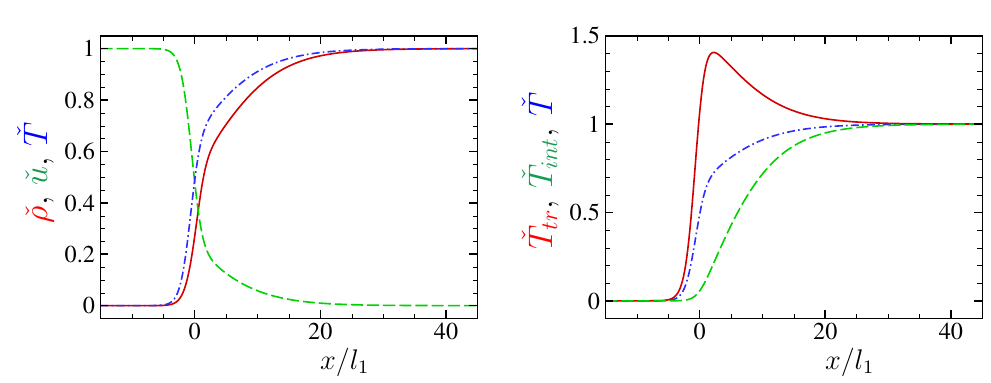
Figure 9. Profiles of ˇ ρ , ˇ u , ˇ T , ˇ T tr , and ˇ T int at M = 2 in the case of δ = 4, θ = 0.05, and ν = 0 (Pr = 1, µ b / µ = 7.619). See the caption of Figure 8.